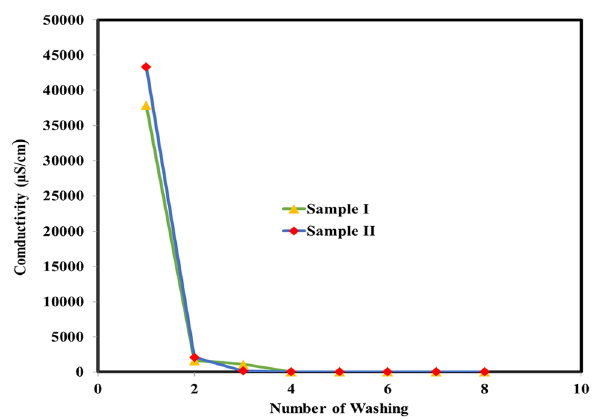
Fig. 6 Total dissolved solids (TDS) that were measured in terms of conductivity of supernatant used for washing